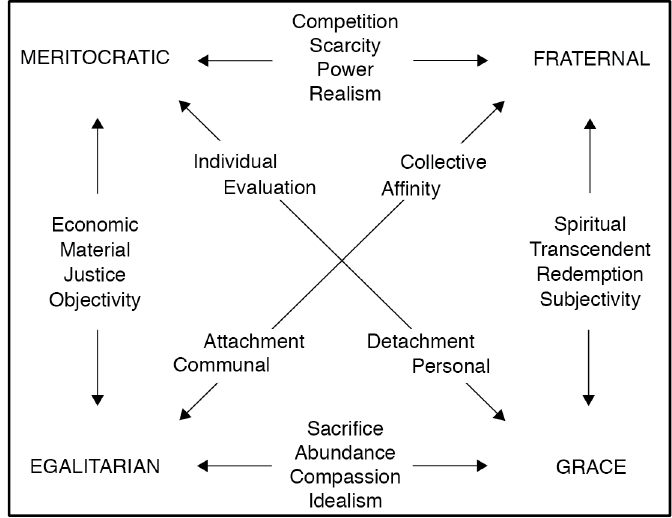
Figure 2. The key characteristics of four opposing moral perspectives that determine opportunities and outcomes within society ([1], p. 24).